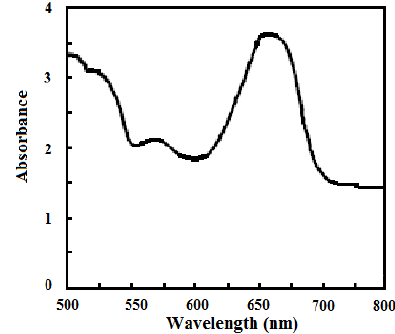
Fig. 2. UV-visible absorbance spectra and absorbance peak at 660 nm